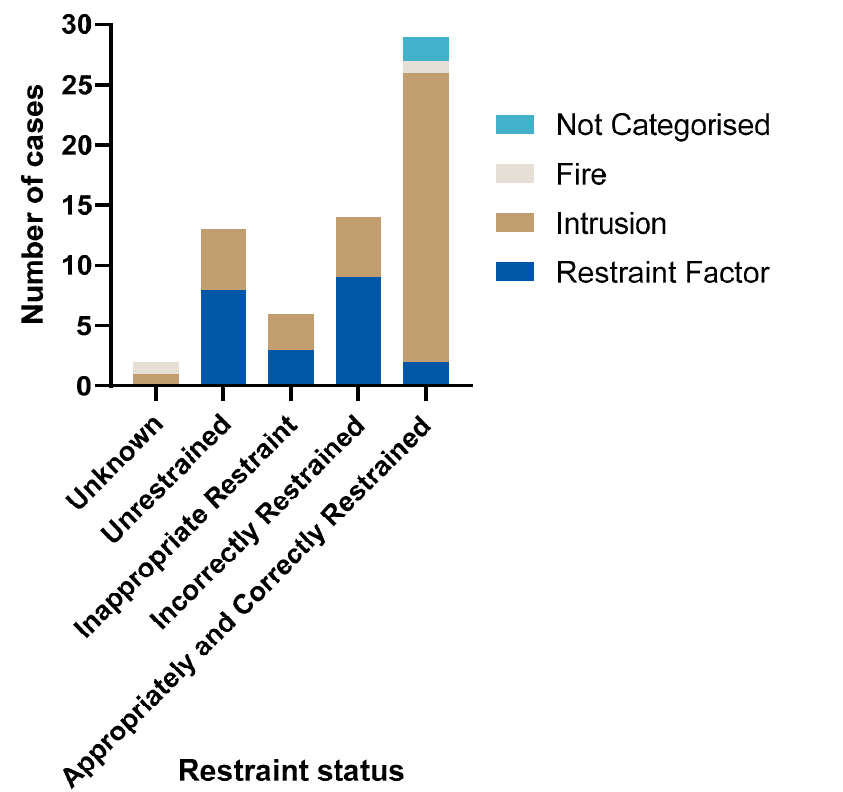
Figure 4. Primary contributor to death by restraint status.